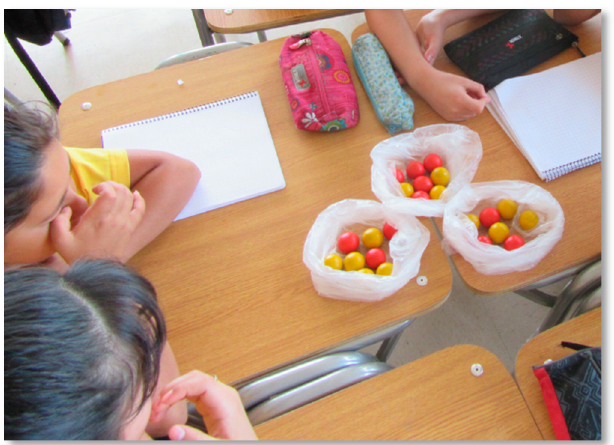
Figure 13. Image capture of 5th grade class.